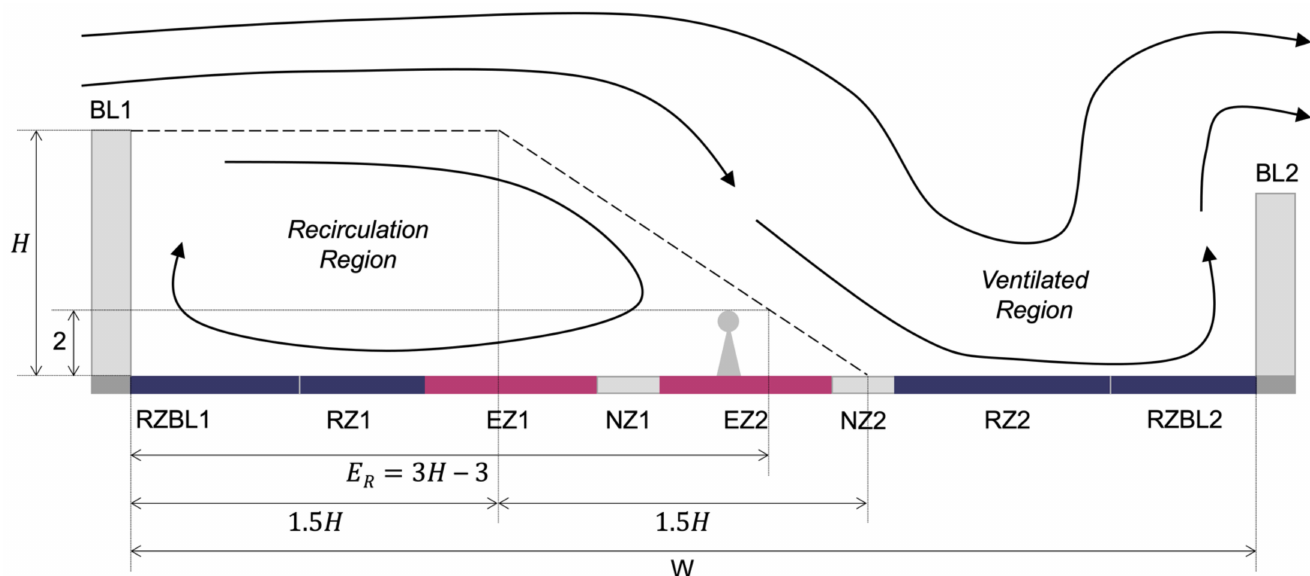
Figure 2. Expected patterns of air flow into, around, and out of our example street section (W > 3 H) when the wind aloft blows from left to right (similar to Figure 1a of [41]). The shape and dimensions of the trapezoidal recirculation region are taken from [41], informing the extent of this region, E R , calculated according to Equation (1) to enclose a person up to 2 m